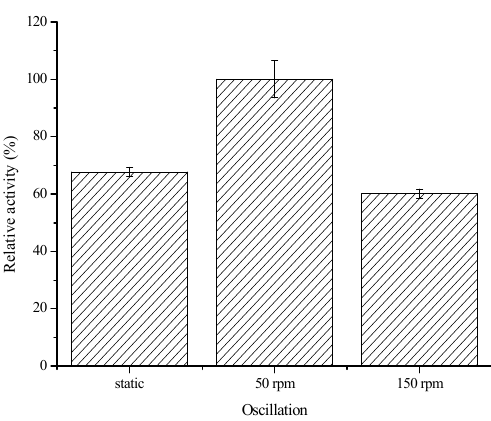
Figure 4. Effect of oscillation on the biocatalytic activity of the immobilized COX-2 ( n = 3).